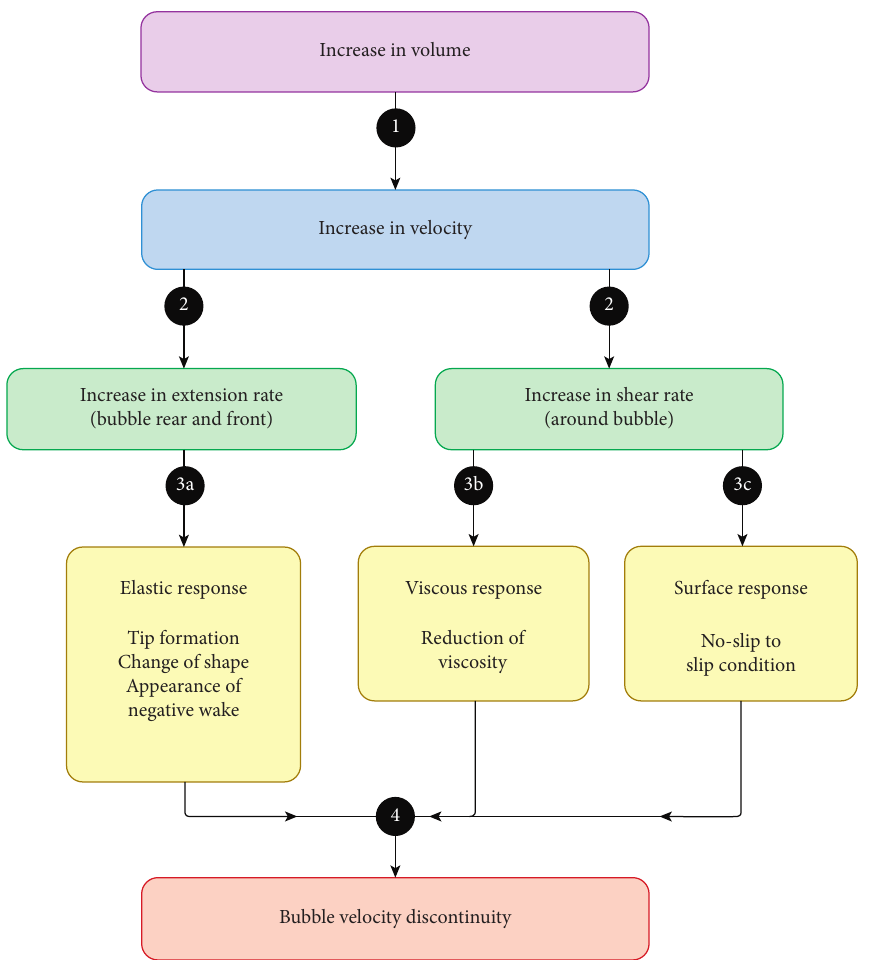
Figure 11: Schematic showing the mechanism for the occurrence of the bubble velocity jump